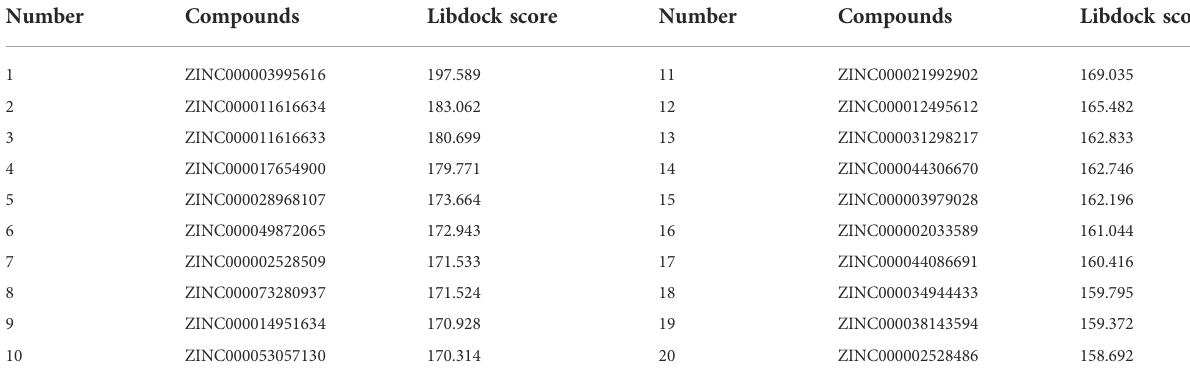
TABLE 1 Top 20 ranked compounds with higher libdock scores than lynparza.